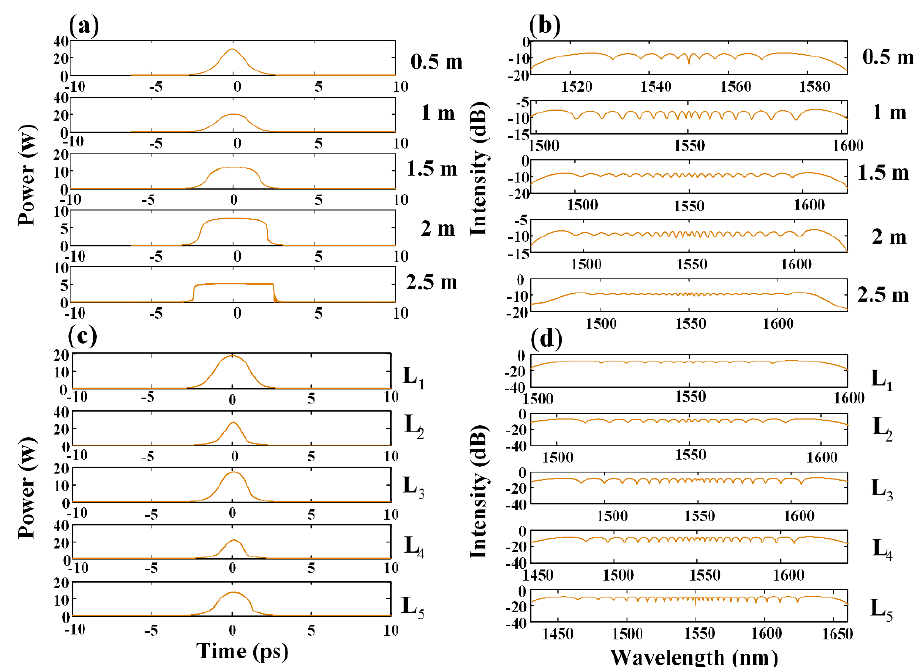
7 of 10 Figure 5. ( a , b ) Evolution of the pulses and the spectrum in 0.7 m ND TMF; ( c , d ) evolution of the pulses and the spectrum in 0.2 m TMF; ( e ) the initial pulse trace; ( f ) the pulse trace after the ND zone; ( g ) the pulse trace after the AD zone. The evolution of a single pulse in the ND TMF and the optimized CSAD-TMF is dis- cussed below. Figure 6a,b show the pulse evolutions when the length of the ND TMF is 0.5 m, 1 m, 1.5 m, 2 m, and 2.5 m, respectively. In the time domain, the linear positive chirp provided by the normal dispersion broadened and reshaped the pulse into a rectangular pulse with an approximate flat top, while the leading anti-trailing edges became steeper. The corresponding spectrum was widened to cover 1500–1600 nm, and then the flatness was gradually improved when the transmission length exceeded 2 m. Finally, a flat optical frequency comb in the range of 1500–1600 nm was obtained. For the CSAD-TMF, the length of each segment is 𝐿 1 = 0.7m (ND), 𝐿 2 = 0.2 m (AD), 𝐿 3 = 0.3 m (ND), 𝐿 4 = 0.05 m , and 𝐿 5 = 0.3 m , respectively, as shown in Figure 1. In Fig- ure 6c,d, 𝐿 𝑛 (𝑛 = 1,2,3,4,5) in the figure represents the output result when passing the nth segment in the CSAD-TMF. According to the pulse evolutions and spectrum shown in Figure 6c,d, the AD zones 𝐿 2 and 𝐿 4 compressed the pulse, but the corresponding spec-